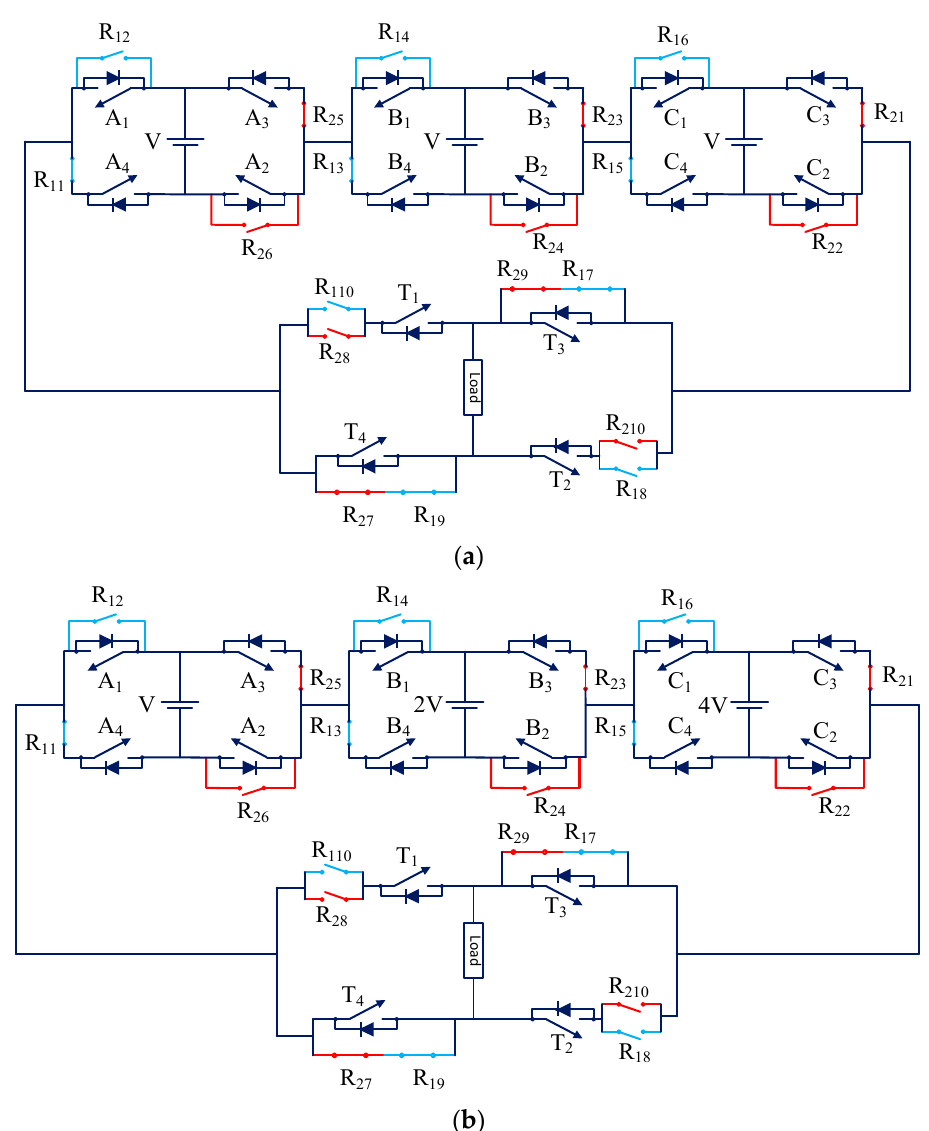
Figure 44. ( a ) Single-phase seven-level FT MLI (TP47) [80]. ( b ) Single-phase fifteen-level FT